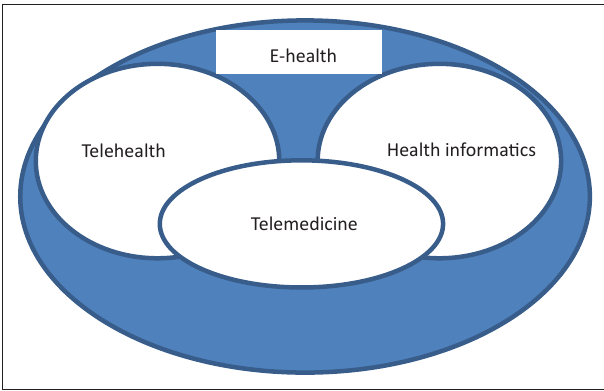
FIGURE 1: Various services as part of the E-health